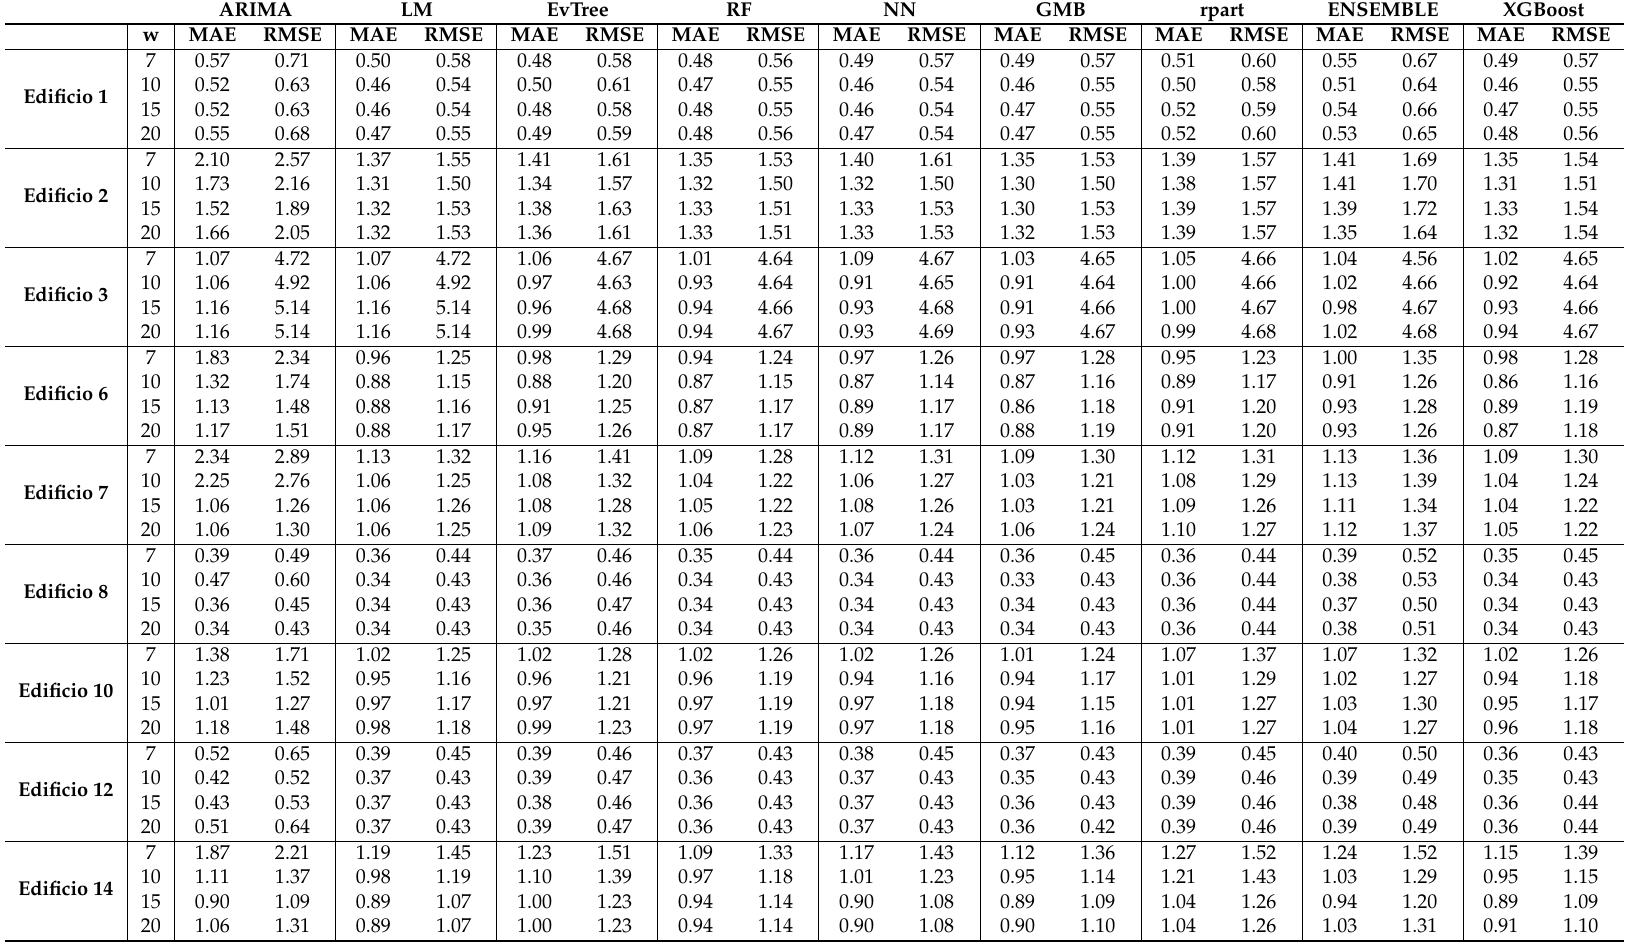
Table 3. Results obtained by all the methods on all the buildings for each value of the historical window